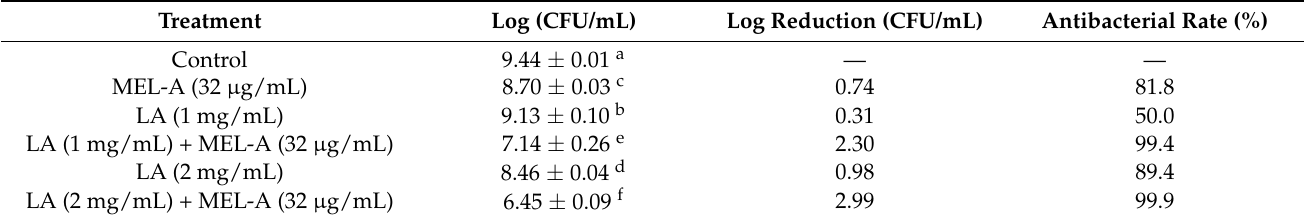
Table 1. Synergistic antibacterial activity of MEL-A and LA on L. monocytogenes